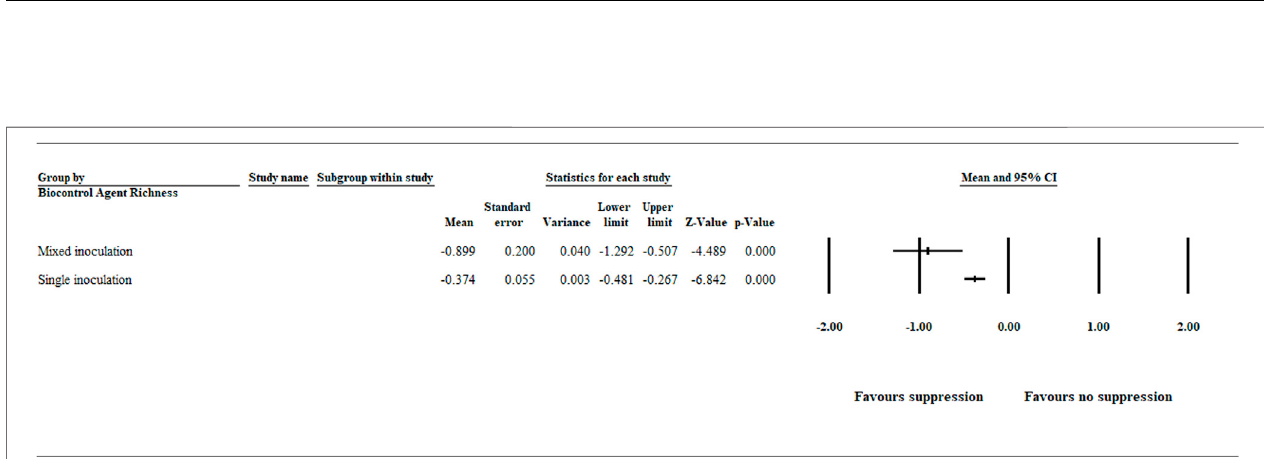
FIGURE2| Effectofbiocontrolagentapplicationmethodonaphanomycesrootrotsuppression.Theanalysisdetectedasigni fi cant( p < .05)negativeeffectsizefor amendment, seed coating, and suspension. The center of the horizontal line depicts the effect size, and the width re fl ects its con fi dence interval. Number of studies: Amendment 35; Seed coating 79; Suspension 45. CI (cid:1) con fi dence interval.